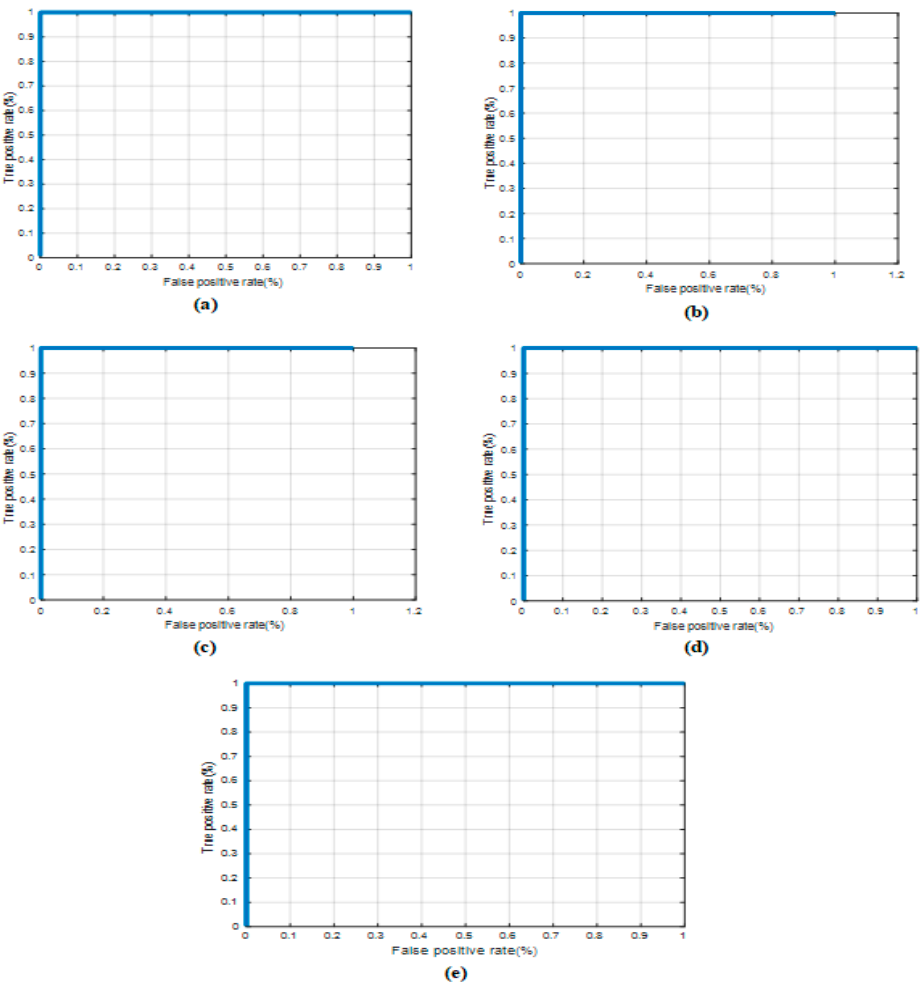
Figure 16. Table 4 shows a comparison of the suggested cancelable fingerprint recognition systems. The table indicates that the DWT domain for kernel encryption with various keys leads to good performance, while retaining a high level of security.